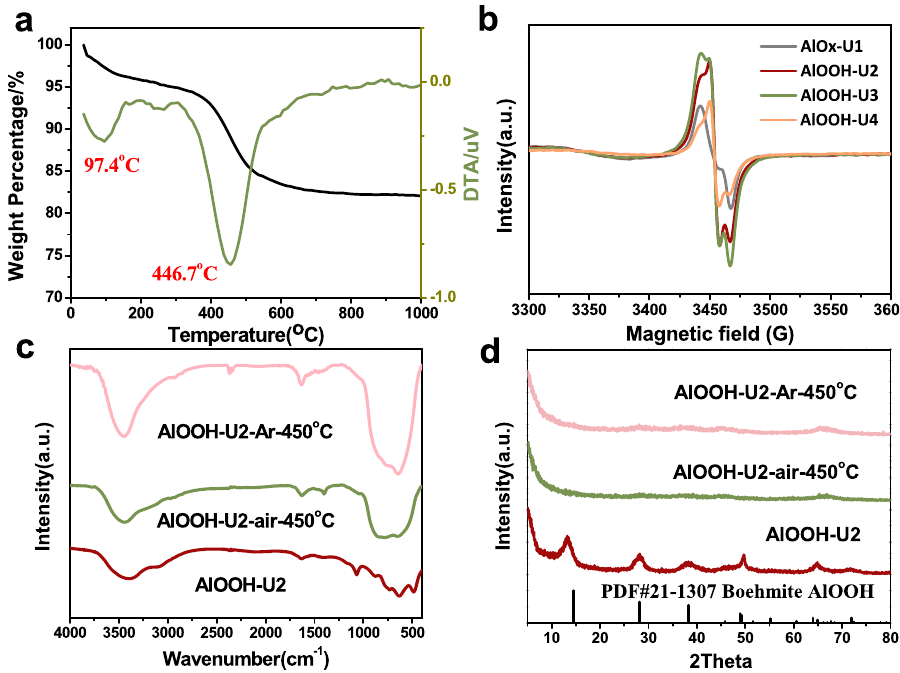
Fig. 4 Characterization of the AlOOH catalyst. a TGA analysis of AlOOH-U2 catalyst. b EPR spectra of different catalysts synthesized by different urea usage. c FTIR spectra and d XRD patterns of AlOOH-U2 catalyst with different treatment conditions.